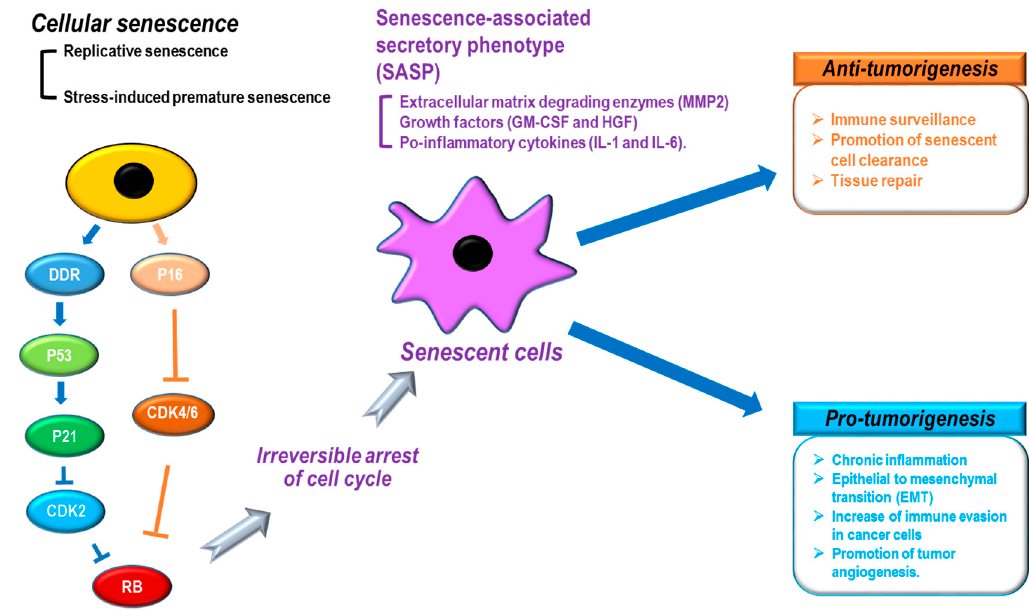
Figure 2. Senescence-associated secretory phenotype (SASP) and tumorigenesis. Cellular senescence by multiple causes: (black) shows distinct phenotypes, including SASP (purple) that can induce anti-tumor (orange) or pro-tumor (sky-blue) development. DDR: DNA damage response, CDK: cyclin-dependent kinase, MMP2: matrix metalloproteinase 2, GM-CSF: granulocyte-macrophage colony-stimulating factor, HGF: hepatocyte growth factor.